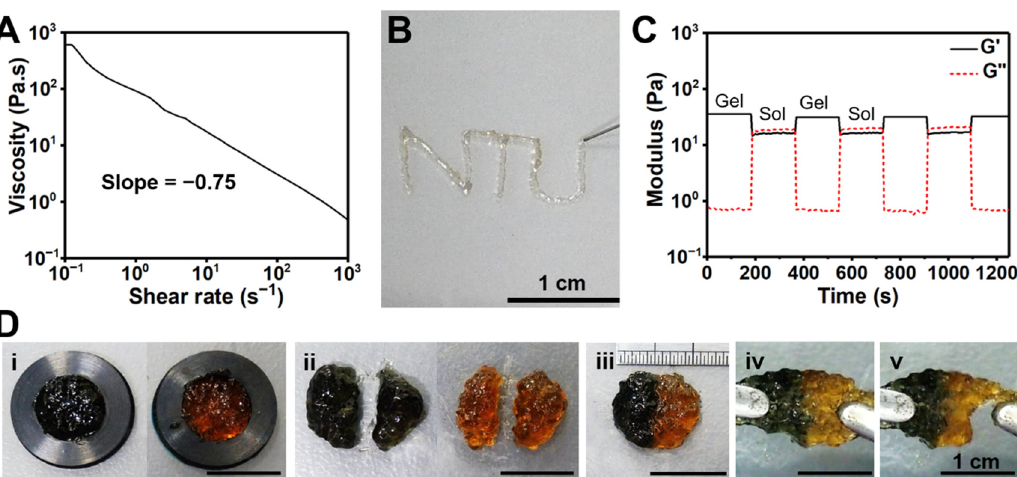
Figure 6. Injectability and self-healing properties of the CC hydrogel (solid content 1.5%). ( A ) The static shear viscosity versus shear rate of the hydrogel. ( B ) Injection of the hydrogel through a 30-gauge syringe needle. ( C ) Damage–healing cycles of the hydrogel evaluated at alternate 1% and 1100% dynamic strains and 1 Hz. ( D ) Gross observation for self-healing of the CC hydrogel: (i) the original hydrogel and the one colored with trypan blue were prepared in disc shape; (ii) each hydrogel was cut in half; (iii) two different pieces of hydrogels were contacted; (iv) the hydrogels were healed to an integral after 24 h; and (v) the hydrogel was pulled to failure but the breaking site was not at the healed site.